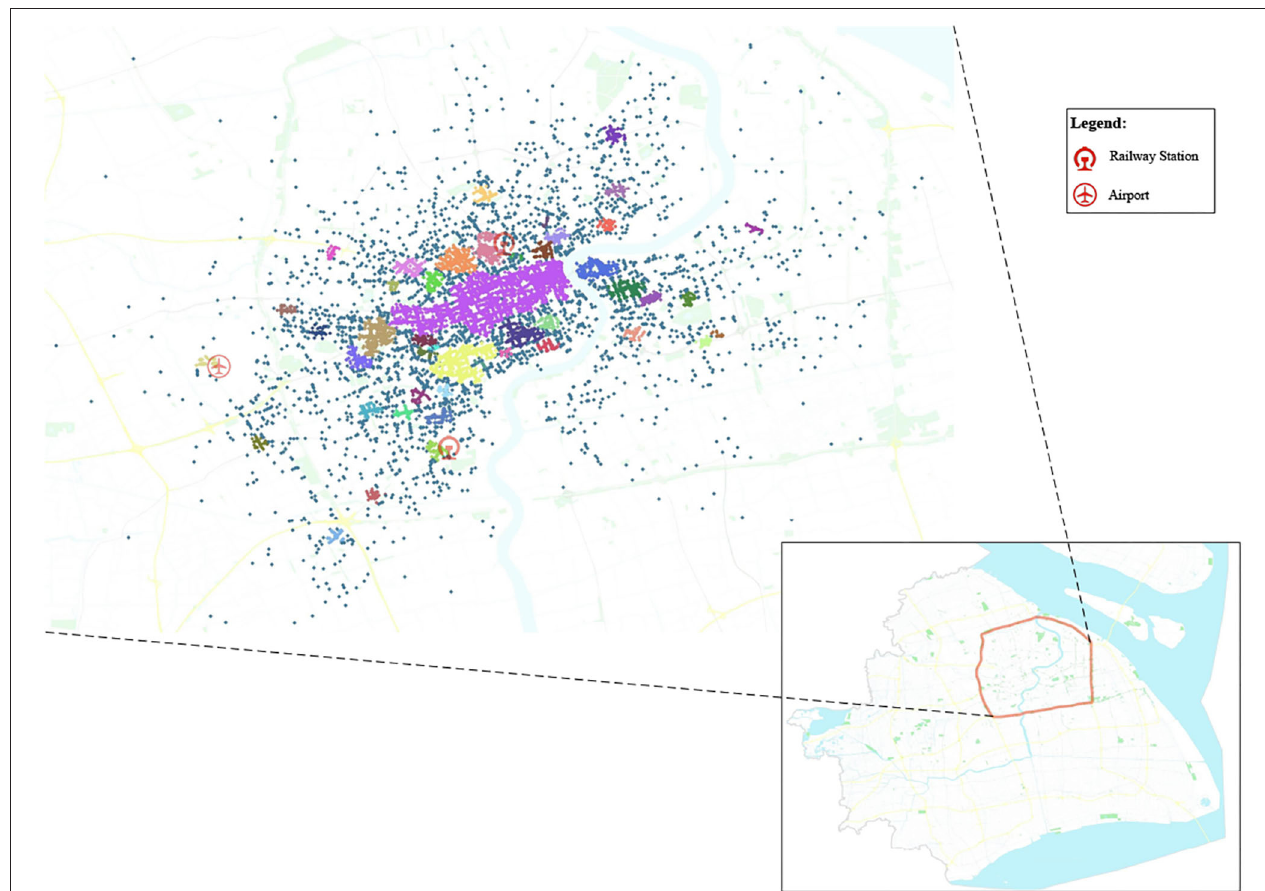
FIGURE 8 | The geographical distribution of